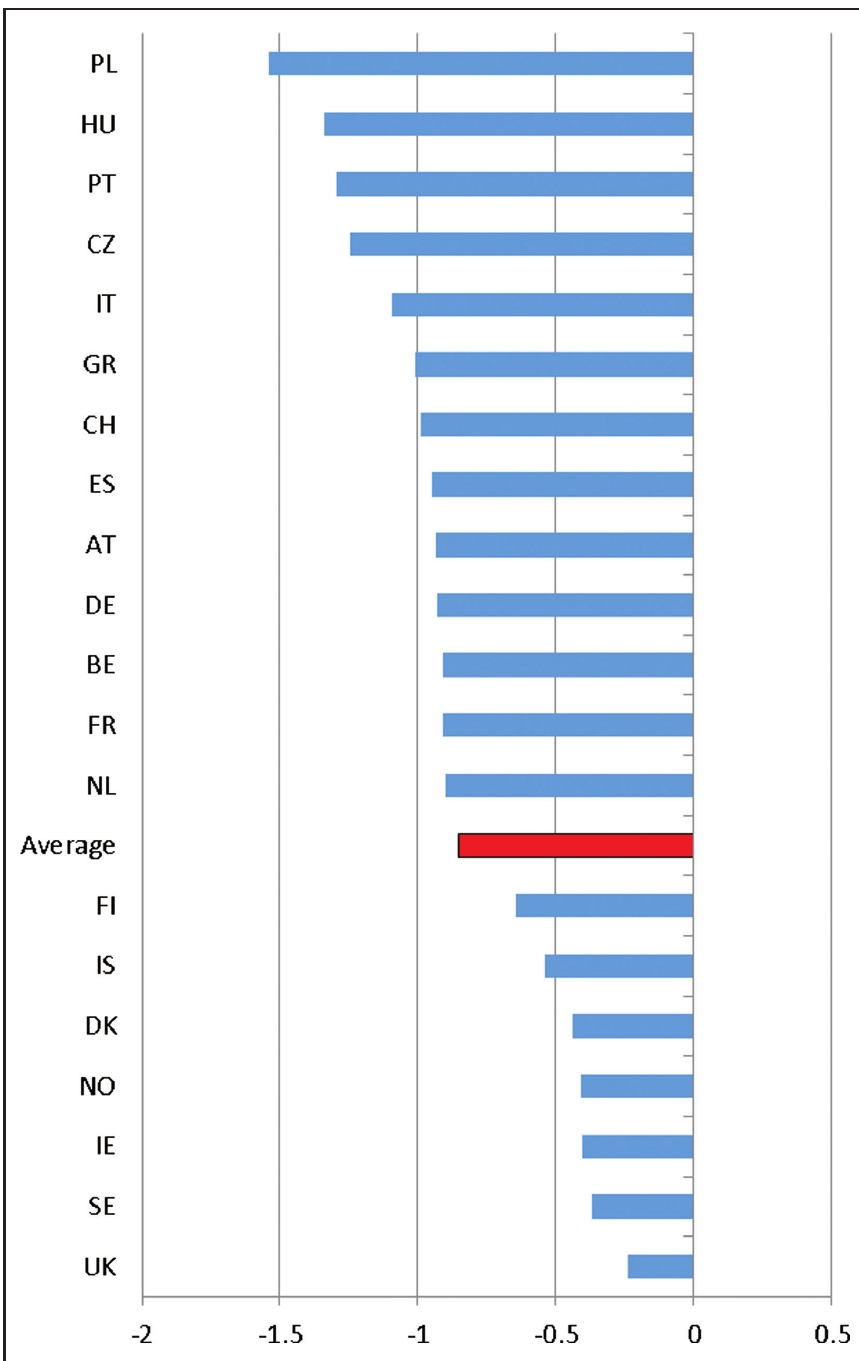
Figure 4 Product market reforms between 1998 and 2013 (change in the PMR OECD index). Note: Luxembourg, Slovak Republic, Estonia, and Slovenia are not presented in the graph because data are not available at the beginning of the